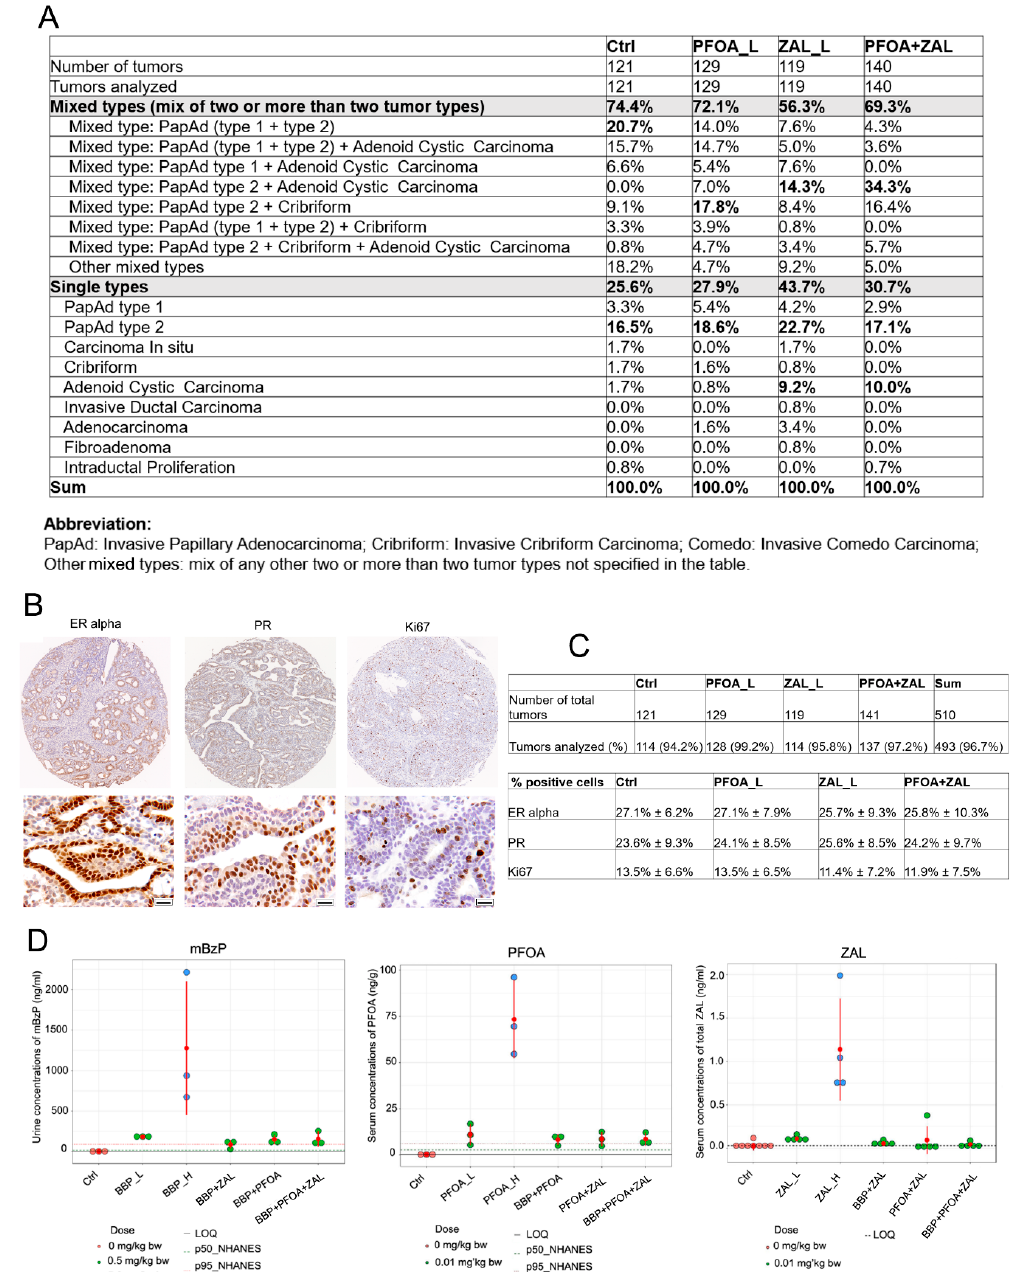
Figure 7. Histopathological analysis and molecular classification of rat mammary tumors: The histopathological type of each tumor was presented as single type when only one histopathological type was found on the tumor, or mixed type when two or more histopathological types were observed on a tumor. ( A ) Histological evaluation of the rat mammary tumors. ( B ) IHC analysis of Ki67, ER alpha, and PR in rat mammary tumors. Upper panel: representative image of one tissue microarray core of each staining. Bottom panel: one high-magnification (40× objective) field showing the staining of the cell nuclei. Scale bar: 20 µm. ( C ) Tables show sample size for IHC analysis and the percentage of positive cells for each staining. Data are presented as the mean ± STD. ( D ) Measurement of the BBP metabolite mBzP in urine, and serum concentrations of PFOA and ZAL at the age of 43 days—1 day after the last administration. NHANES: National Health and Nutrition Examination Survey; LOQ: limit of quantification; p50_NHANES and p95_NHANES represent the 50% and 95% percentile levels in the NHANES 2002–2012 data,